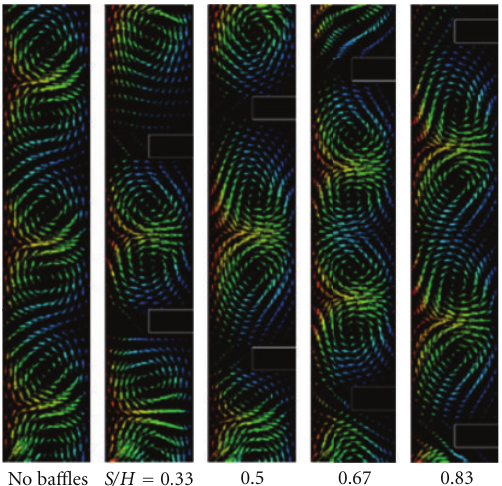
Figure 6: Flow patterns in presence of horizontal ba ffl es in the annulus